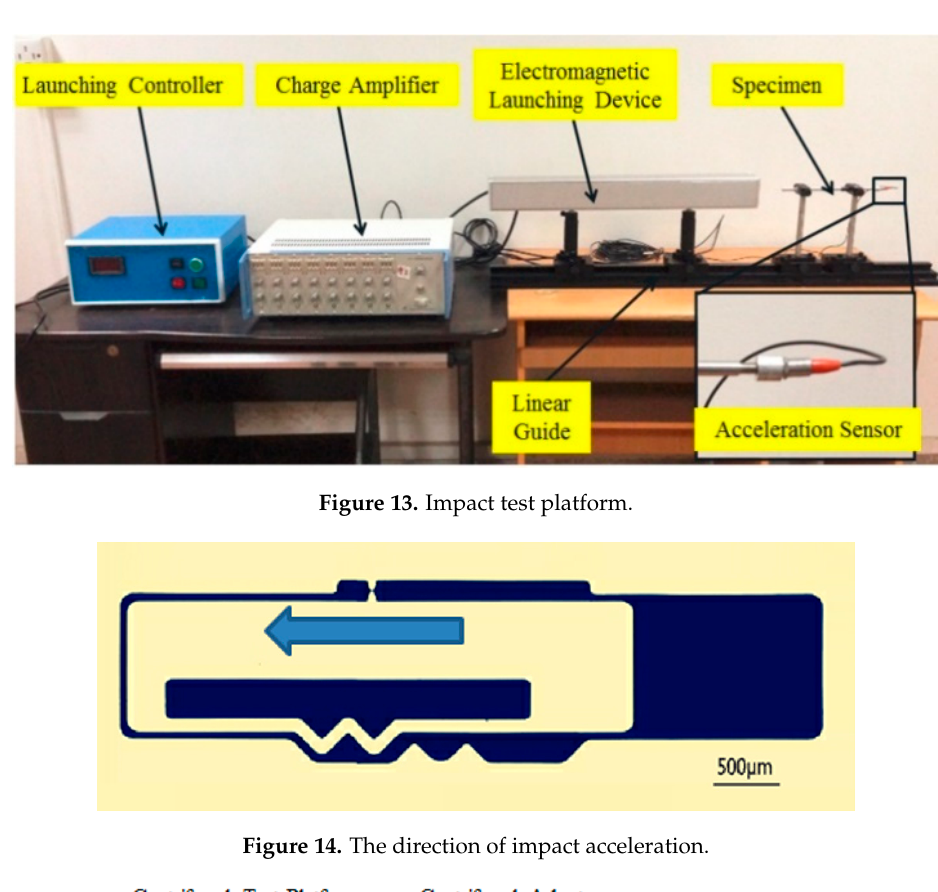
( b ) Figure 12. The micro-sample of the elastic-beam delaying mechanism ( a ) overall view, ( b ) partial view. 5. Test There are two kinds of tests for delaying mechanism: